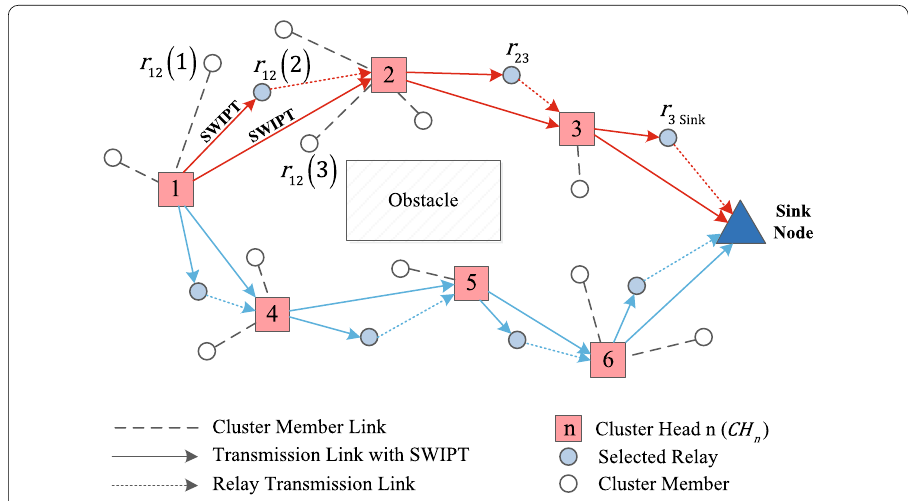
Fig. 1 A multi‑hop clustered cooperative wireless sensor network with